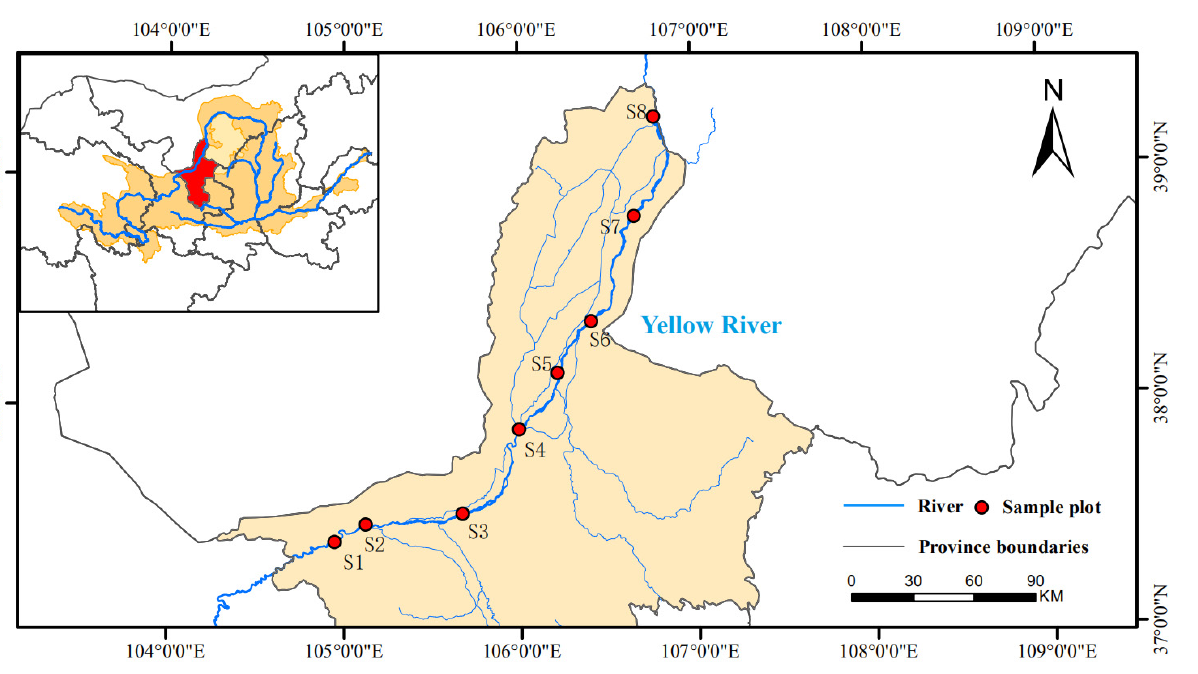
Figure 1. Distribution of sampling sites in the Ningxia section of the Yellow River. Three parallel samples (2 L each) at 50 cm depth were randomly collected at the sampling point and mixed as water samples (6 L). After labeling, the water sample was placed in a polyethylene sampling bottle and stored in an incubator below 4 ◦ C before being transported to the laboratory. The water samples for DNA analysis were filtered through 0.22 µ m filter membrane within 24 h (under sterile conditions). The filter membranes were stored at − 80 ◦ C until DNA extraction. The sample pretreatment process was carried out in a sterile environment to avoid the contamination of samples by external bacteria. Sediment samples were collected using a modified Peterson mud collector. Three parallel surface sediment samples (sampling depth: 10 cm) were randomly collected from each sample